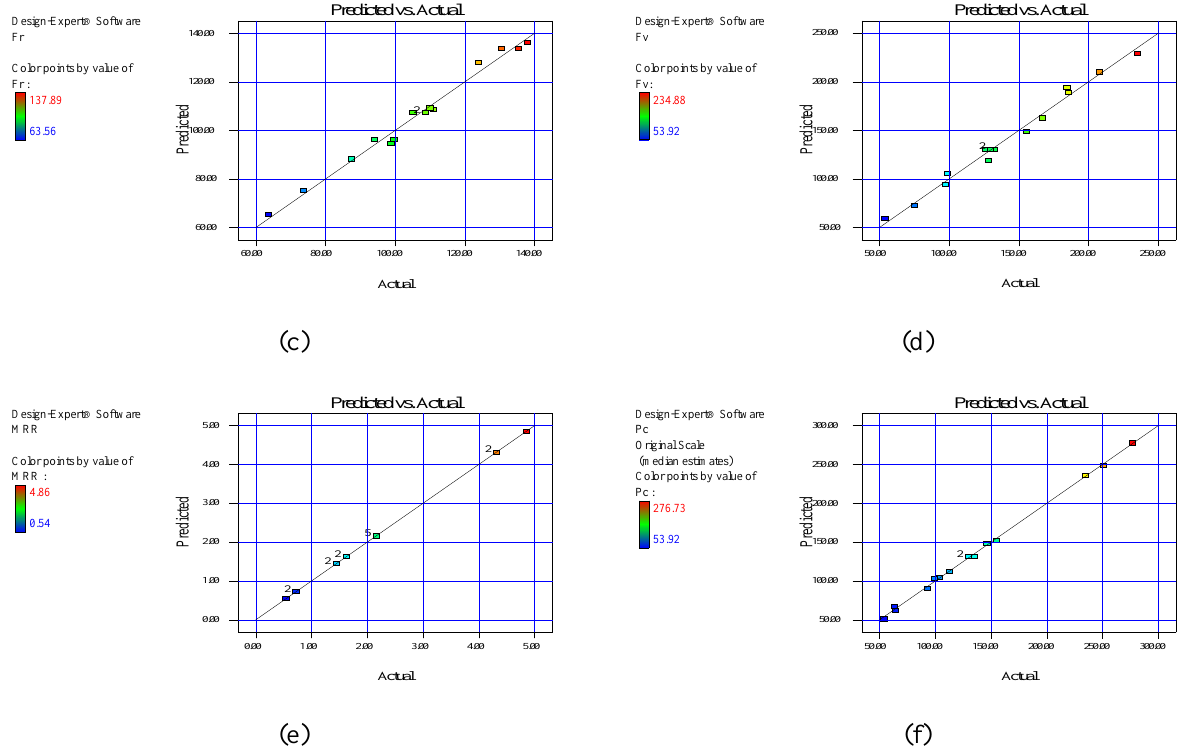
Fig. 18. Comparison between actual and predicted values for Ra (a), Fa (b), Fr (c), Fv (d), MRR (e) and Pc